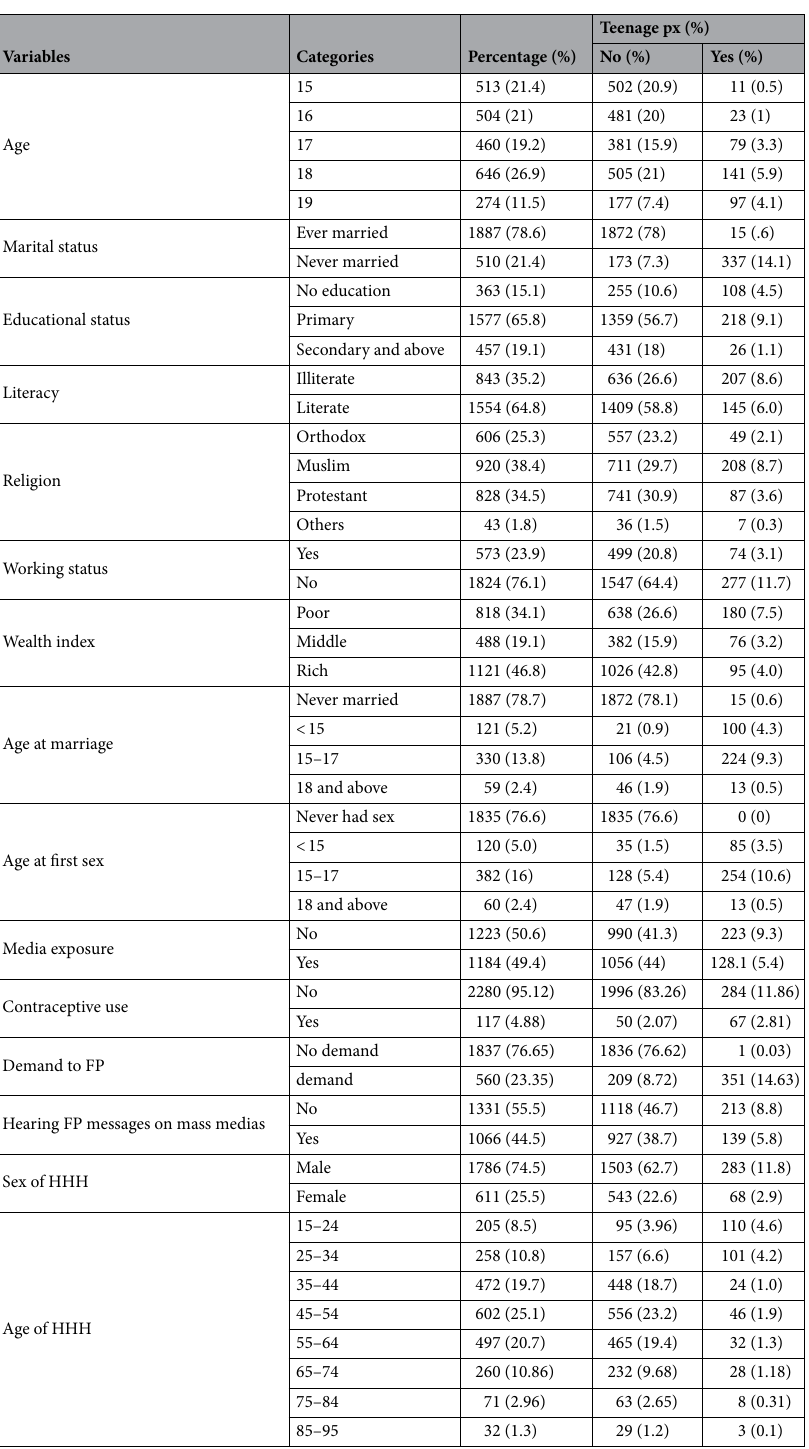
Table 1. Individual level characteristics and teenage pregnancy distribution (n = 2397), Ethiopia 2016. FP : family planning, HHH : household head